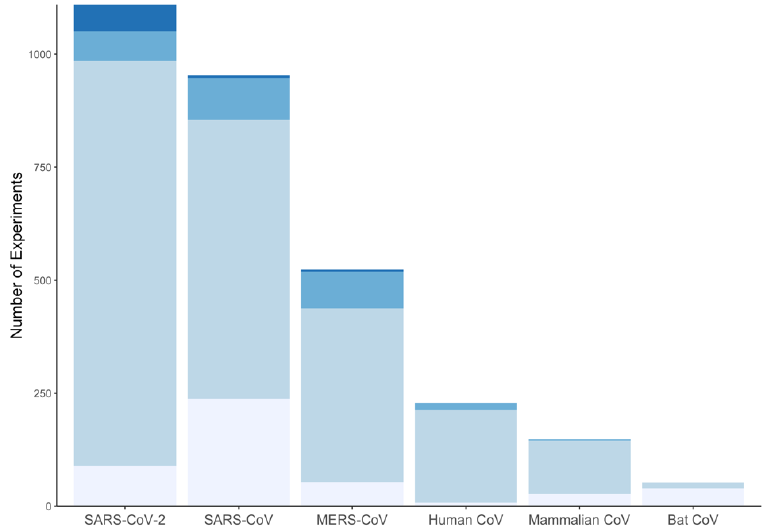
Figure 2. The distribution of biochemical experiments (lightest), cell culture experiments (light), animal model experiments (dark), and clinical studies (darkest) for the six categories of virus in the Coronavirus Antiviral Research Database (CoV-RDB). The cell culture experiments also include entry assay